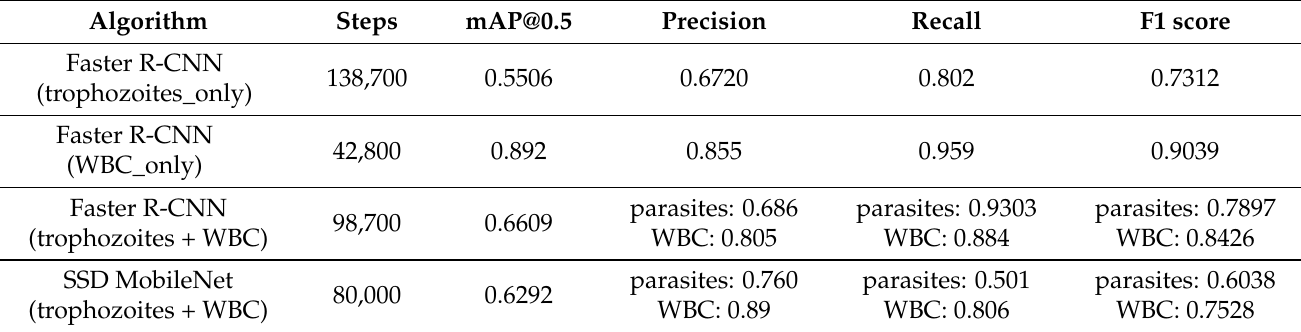
Table 2. mAP@0.5, precision, and recall performance for Faster Regional Convolutional Neural Network (R-CNN) model for detection of malaria parasites and